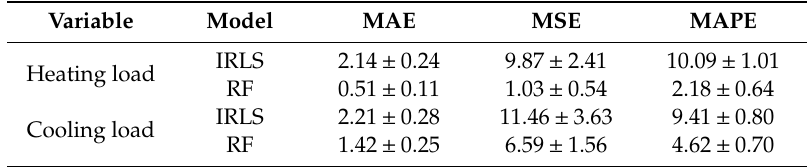
Table 3. Parameters of quality for models of energy e ffi ciency dataset in reference